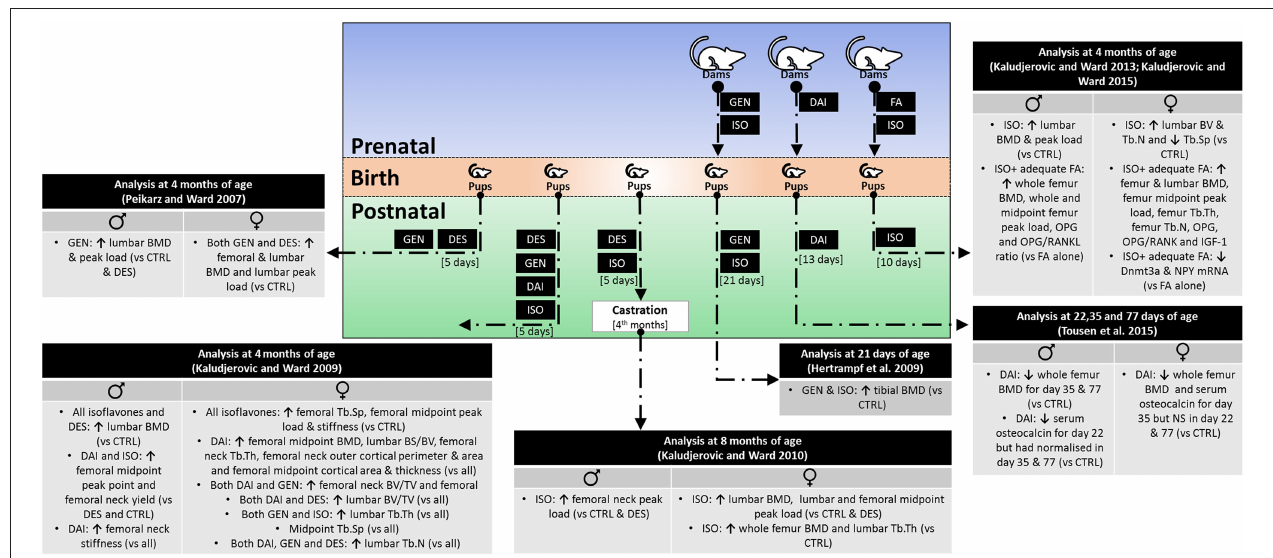
FIGURE 1 | Skeletal effects of early life exposure to soy isoflavones. BMD, bone mineral density; BV/TV, bone volume over total volume; CTRL, control; DAI, daidzein; DES, diethylstilbestrol; Dnmt3a, DNA methyltransferase 3a; FA, folic acid; GEN, genistein; IGF-1, insulin-like growth factor-1; ISO, isoflavone mixture (DAI + GEN); NPY, neuropeptide Y; OPG, osteoprotegerin; RANKL, receptor activator of nuclear factor kappa-B ligand; Tb.N, trabecular number; Tb.Th, trabecular thickness; Tb.Sp, trabecular